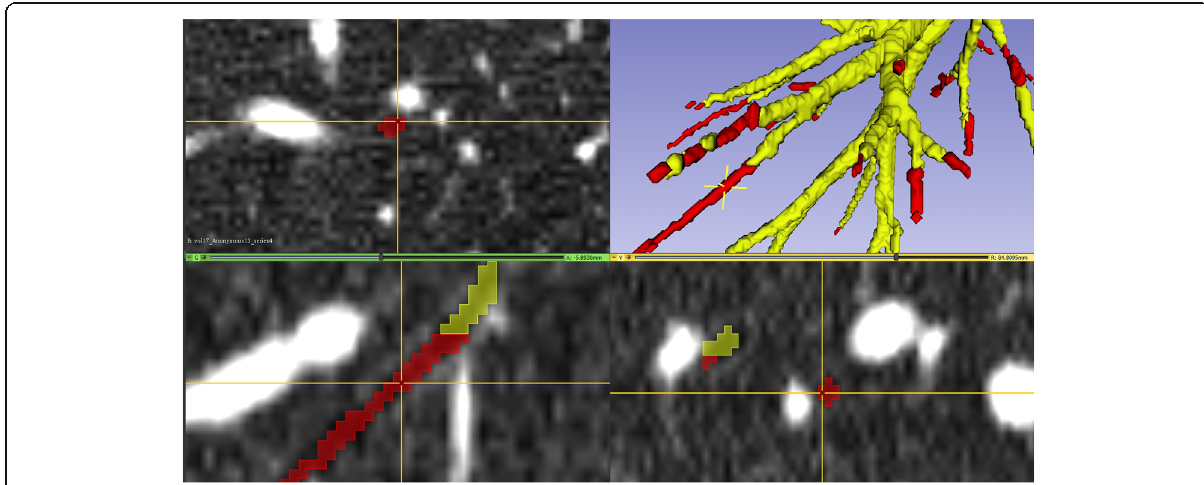
Fig. 1 A 3D Slicer workspace for fast identification and correction of incomplete airways. Yellow: incomplete airway segmentation of an ImaLife participant. Red: manual correction of the